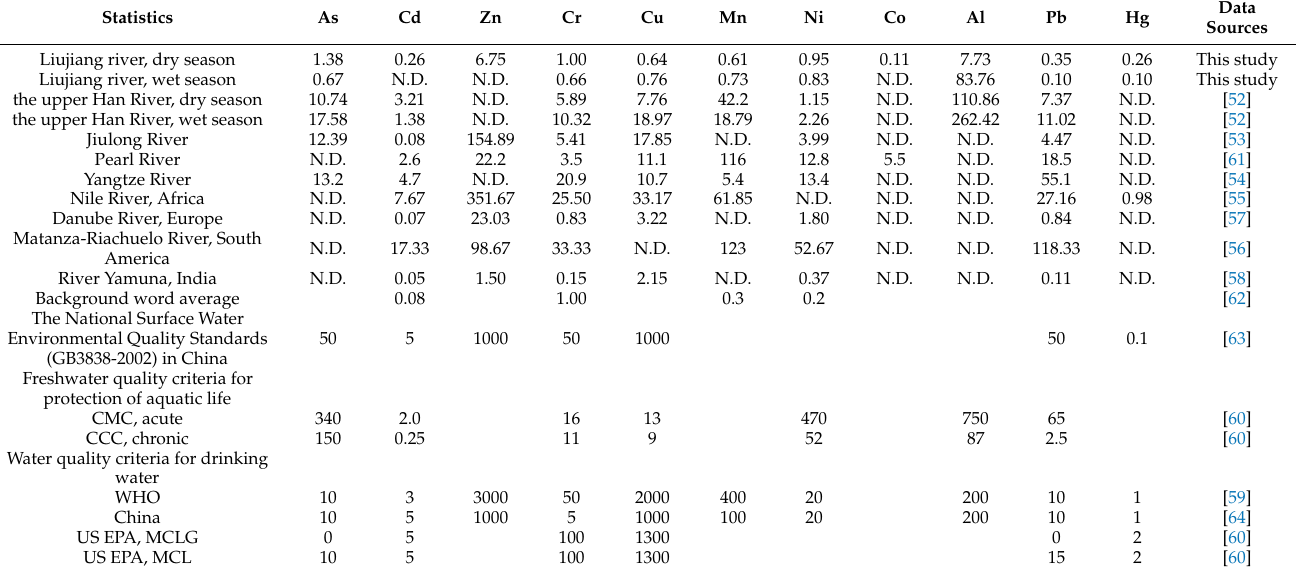
Table 3. Analysis of variance for heavy metal concentrations in the dry and wet seasons in the Liujiang River and comparison with other studies and guidelines (unit in µ